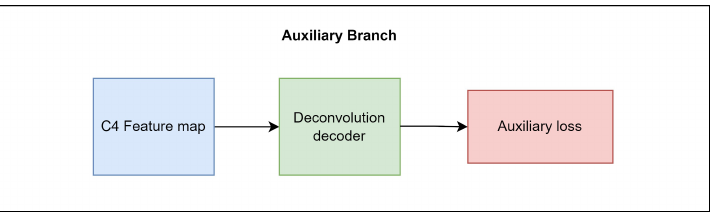
Figure 7. The auxiliary branch of CloudRCNN (auxiliary loss).